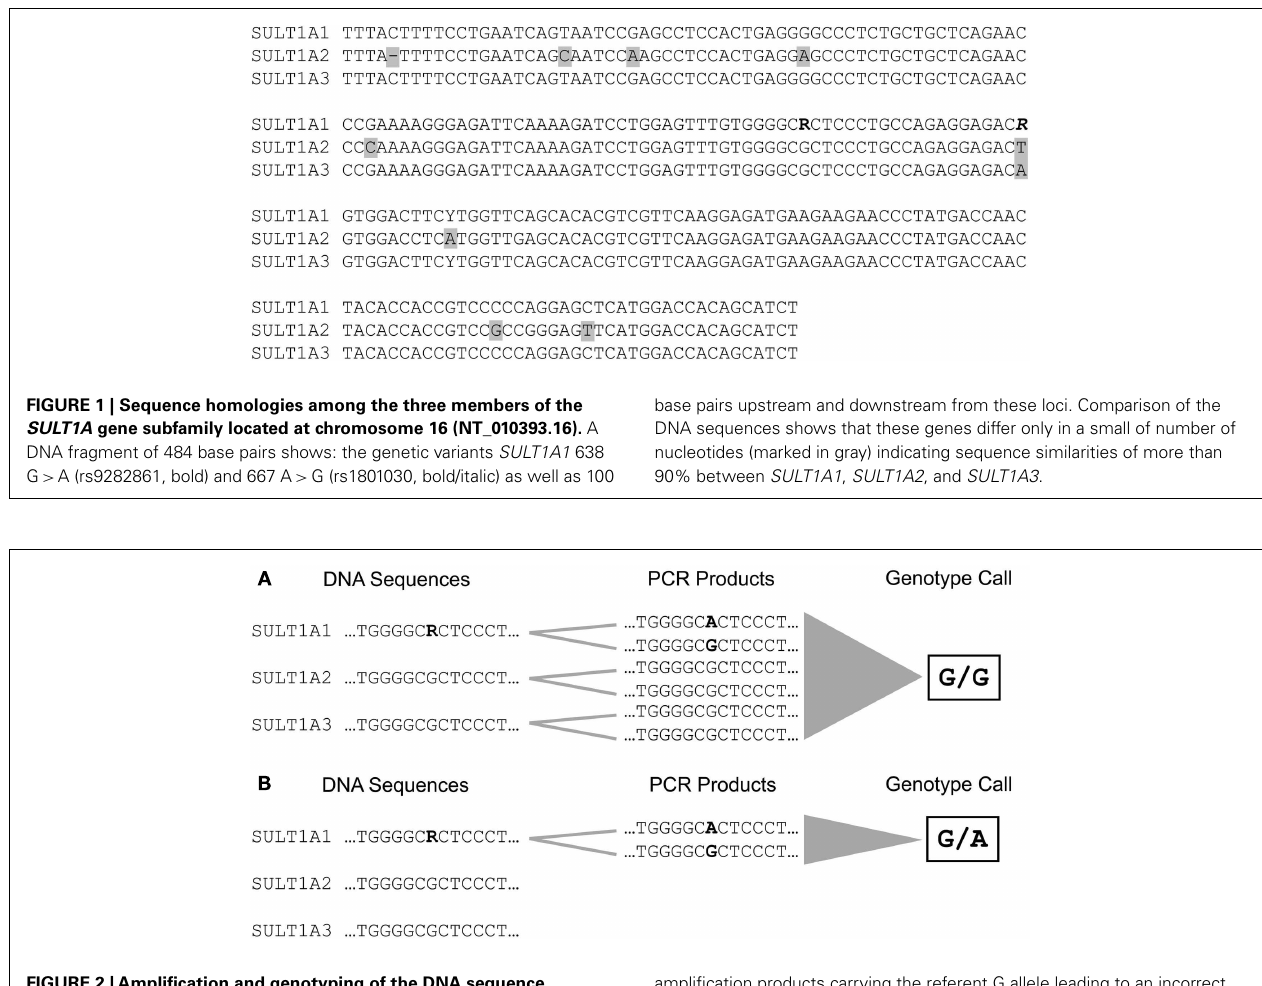
FIGURE 2 |Amplification and genotyping of the DNA sequence comprising the SULT1A1 638 G > A (rs9282861) polymorphism. (A) The selection of unspecific primer binding sites lead to simultaneous amplification of SULT1A1 , SULT1A2 , and SULT1A3 due to their high degree of sequence homology.This results in accumulation of